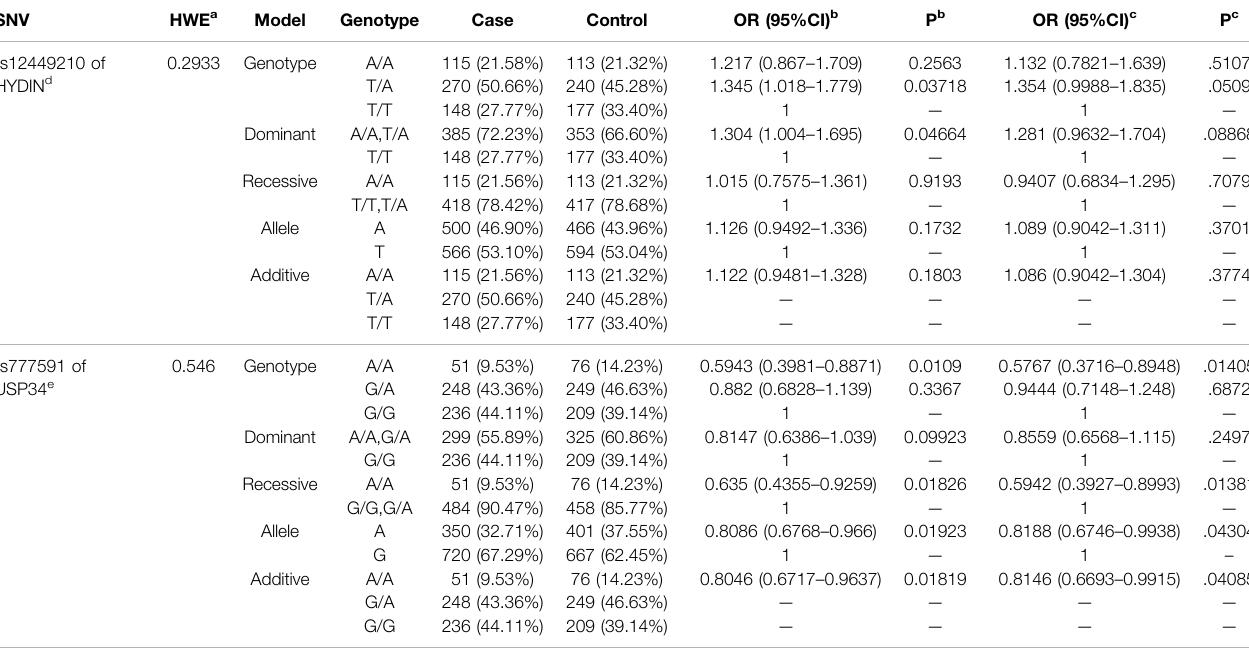
TABLE 2 | Analysis of the genotypes for rs12449210 of HYDIN and rs777591 of USP34 .